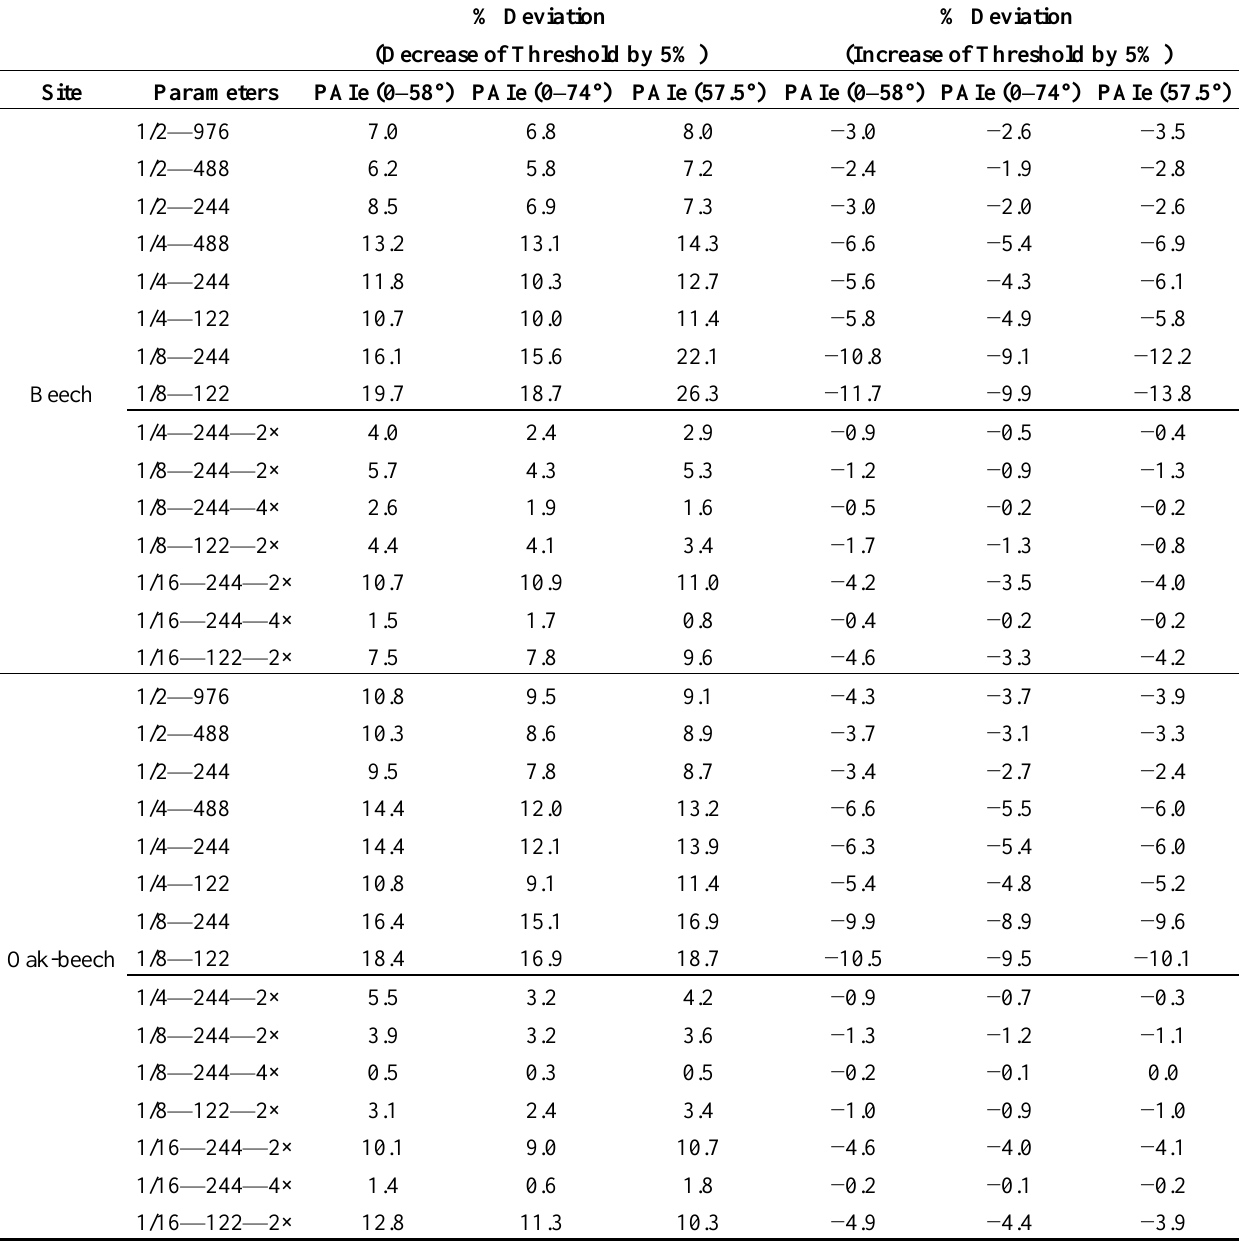
Table 3. ( a ) The effect of threshold variation on the PAI and with different LAI calculation methods. ( b ) The effect of threshold variation on the PAI calculated from the leaf-on scans and with different LAI calculation e